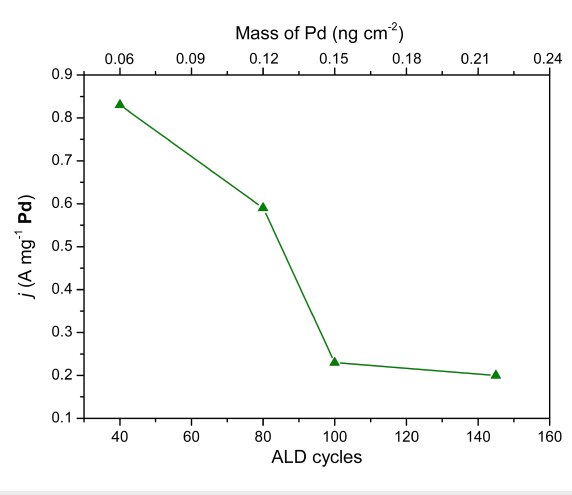
Figure 13: Peak current densities of the electrooxidation of 1 M HCOOH in 0.5 M H 2 SO 4 with various Pd contents in the Pd/Ni nanocatalysts, which were obtained with 40 to 145 Pd ALD cycles. The mass of Pd was estimated from the QCM